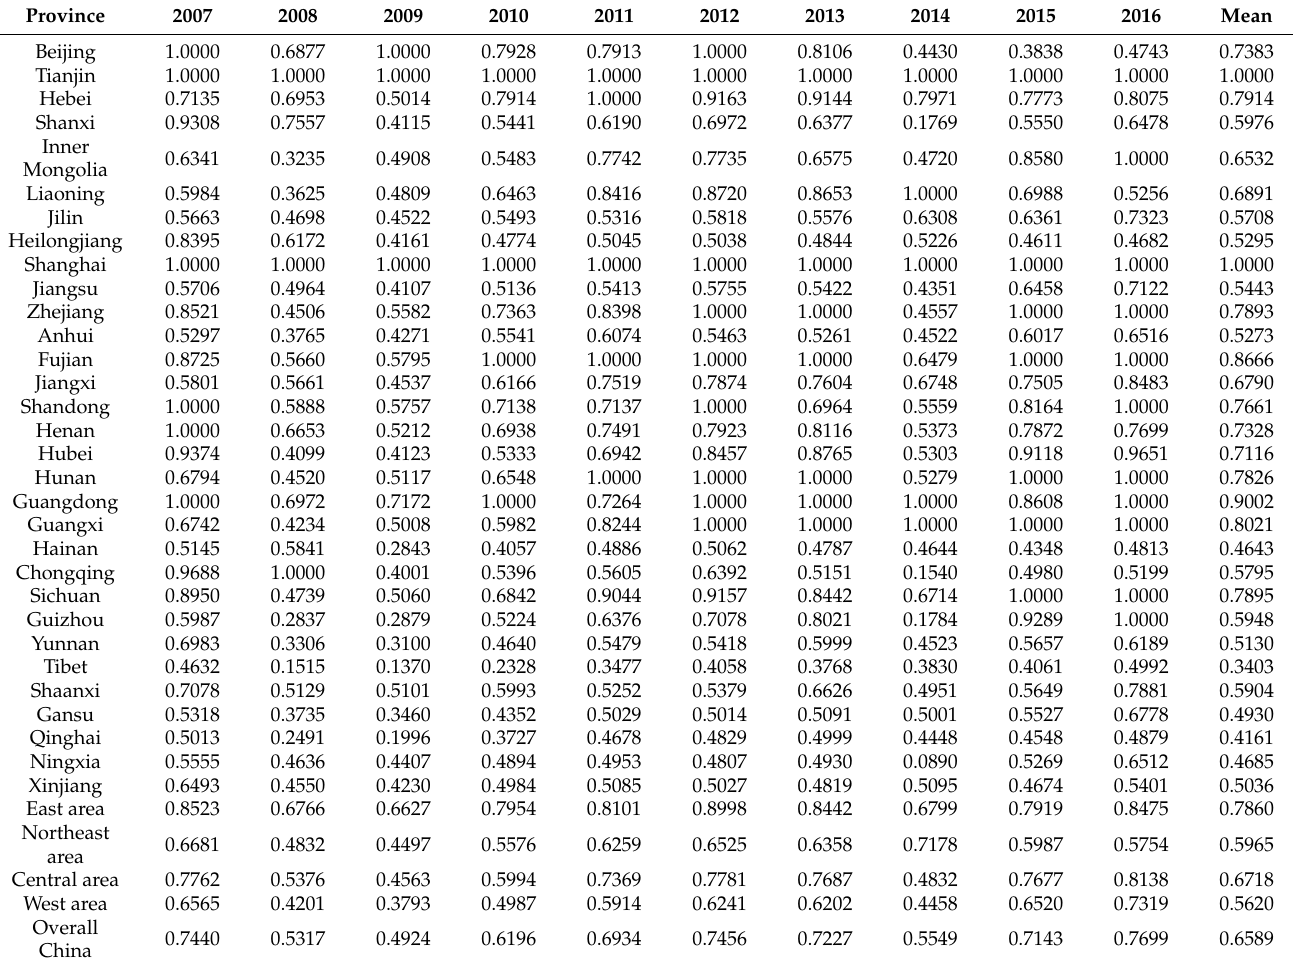
Table 2. The TFSEE in the mining industry of China’s 31 provinces and its four major areas.